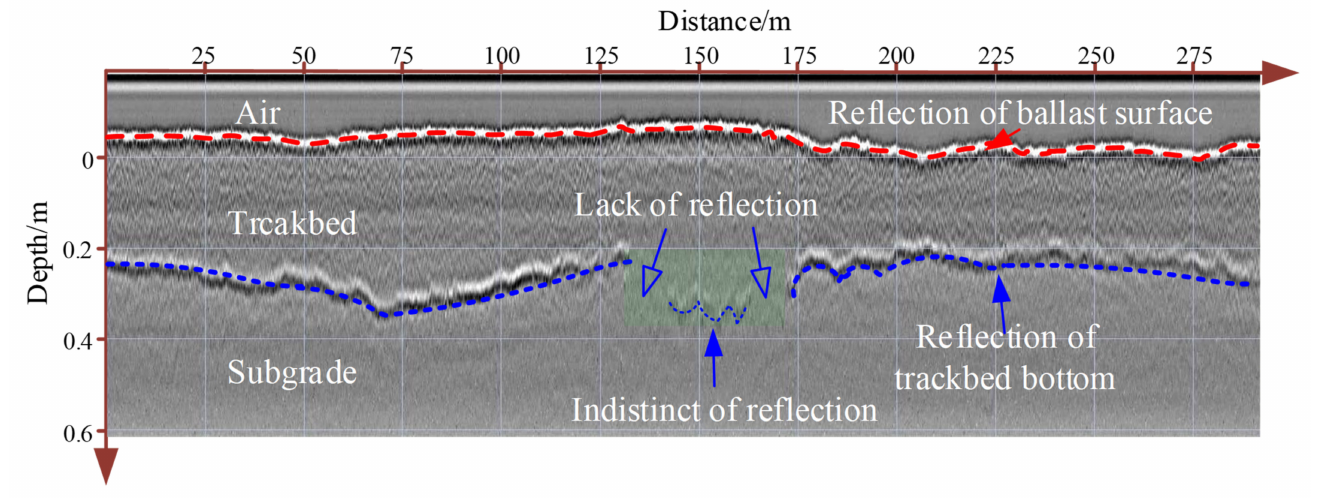
Figure 6. GPR signal reflection from ballast layer